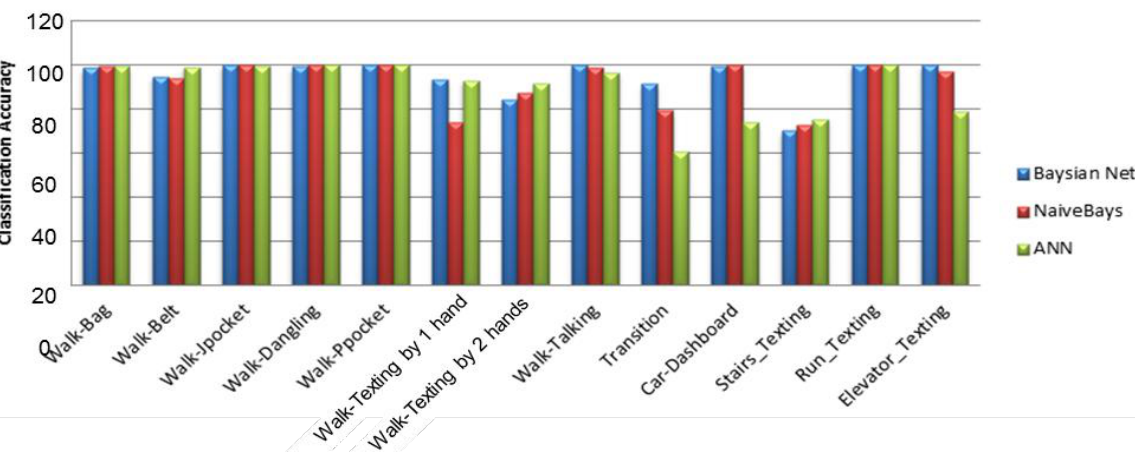
Figure 5. Recognition accuracy rate using different classifier for different activity modes- feature space: four essential features selected by SVM feature evaluator method.